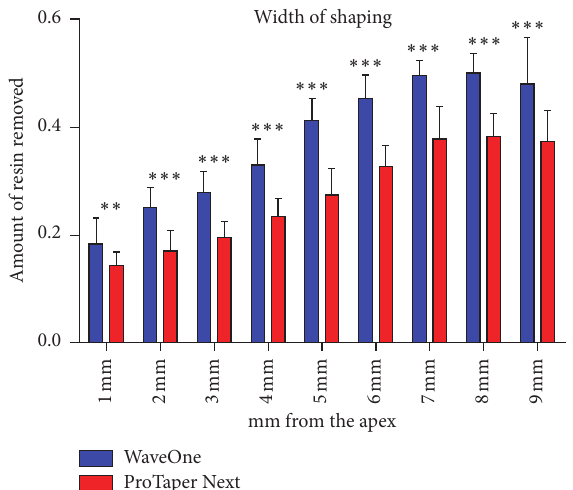
Figure 4: Amount of resin removed at 9-point level ( ∗∗ 𝑃 < 0.01 ; ∗∗∗ 𝑃 < 0.001 ).